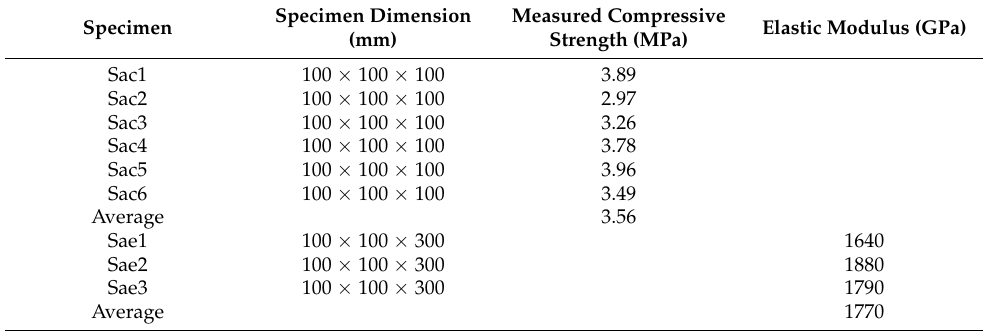
Table 3. Material properties of ALC panel.